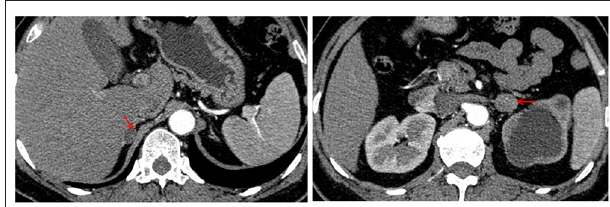
FIGURE 1 | Adrenal enhanced computed tomography (CT) image showing a 16 × 13mm right adrenal tumor and a 20 × 18mm left adrenal tumor (red